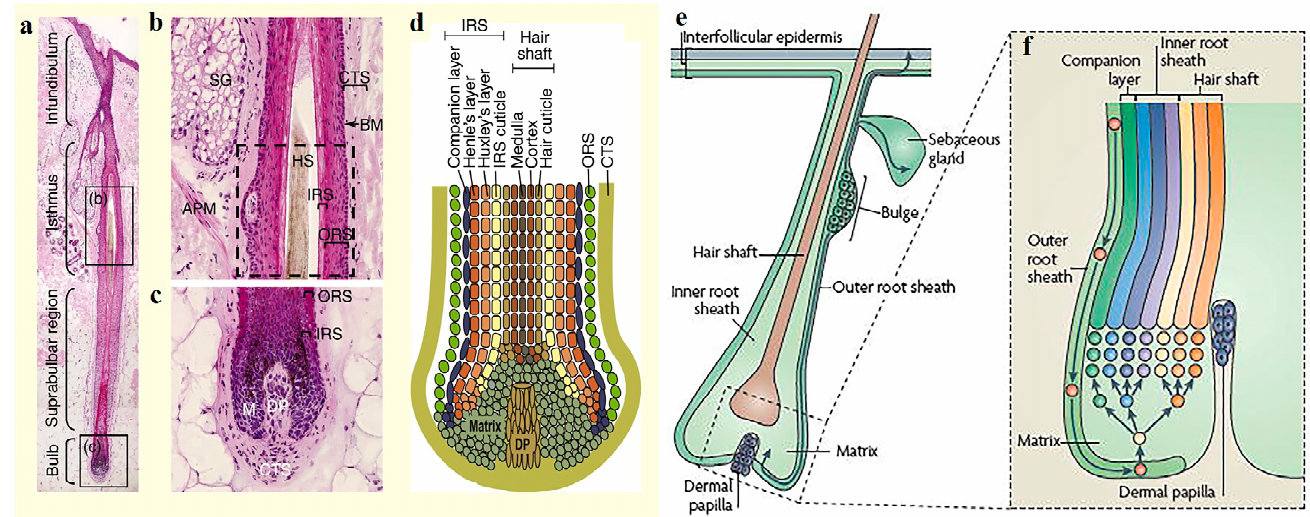
Figure 1. ( a – d ) Human hair follicles (HFs). ( a ) Sagittal section of an HF from the human scalp (anagen VI) showing permanent (infundibulum and isthmus) and anagen-associated (suprabulbar and bulbar area) components. ( b ) High-magnification image of the isthmus. ( c ) High-magnification image of the bulb. ( d ) Schematic illustrating the concentric layers of the outer root sheath (ORS), inner root sheath (IRS), and shaft in the bulb [19]. Copyright 2008 Elsevier Science. ( e , f ) Mouse HFs. During normal conditions, bulge stem cells (SCs) are periodically activated to form a new HF (see part ( e )). As bulge SC progeny move down the ORS to the base of the HF, they subse- quently become matrix cells. After proliferation, these cells di ff erentiate along one of seven hair lineages (see part ( f )) [20]. Copyright 2022 Springer Nature.